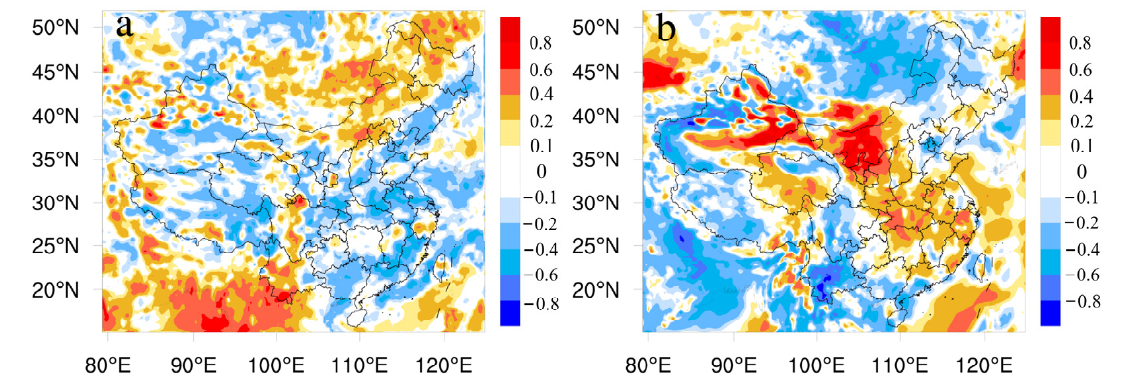
Figure 7. Maps of correlations between dust concentrations and precipitation ( a ), and between dust concentrations and wind speeds ( b ) during the springs of 2000–2020.